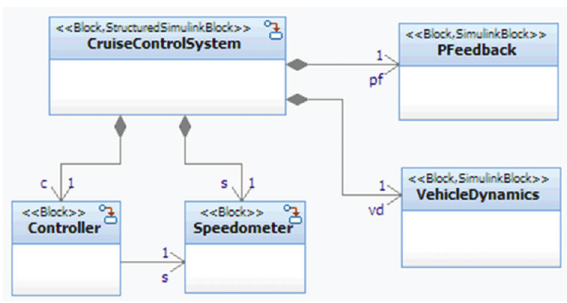
Figure 4: Block definition diagram of a cruise control system.